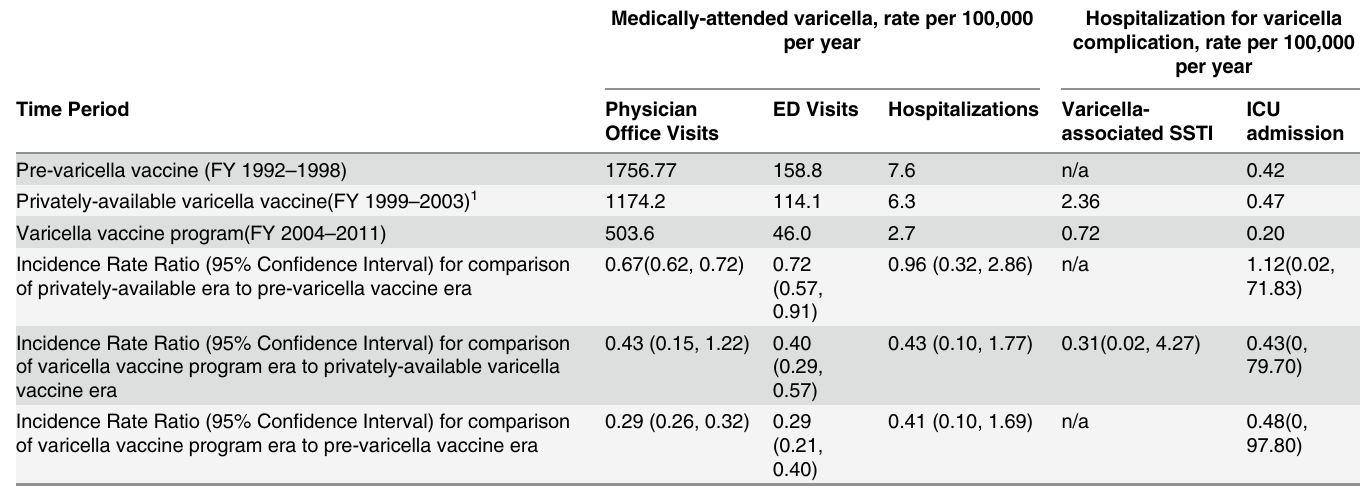
Table 1. Comparison of incidence of medically-attended varicella and hospitalization for complicated varicella in Ontario children among pre-vari- cella vaccine, privately-available varicella vaccine and varicella vaccine program